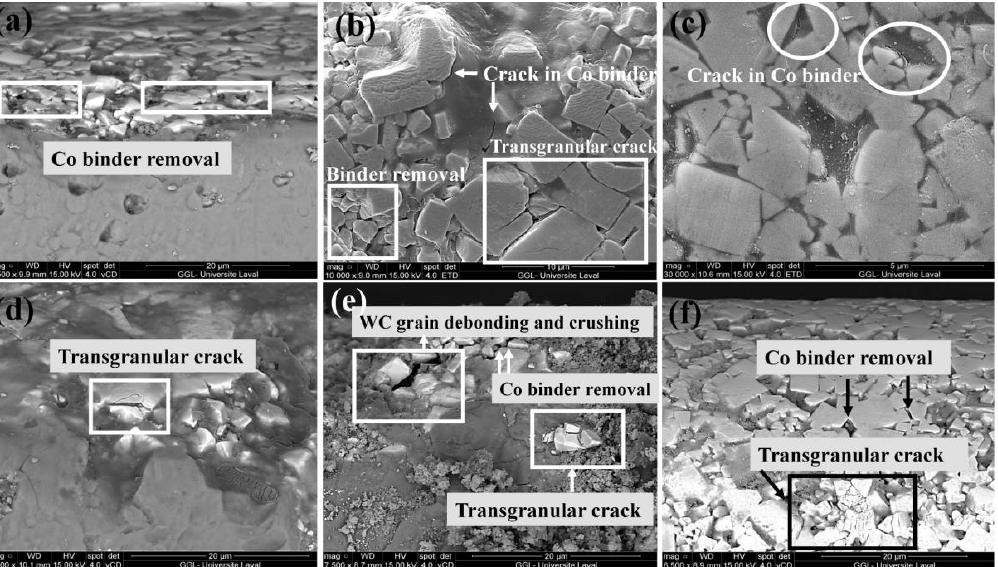
Figure 26. SEM micrographs of the defects on the cutting edges (rake face view): ( a – c ) saws #2, 4, and 6, respectively after 480 min of sawing and ( d – f ) saws #2, 4, and 6, respectively after 960 min of sawing.